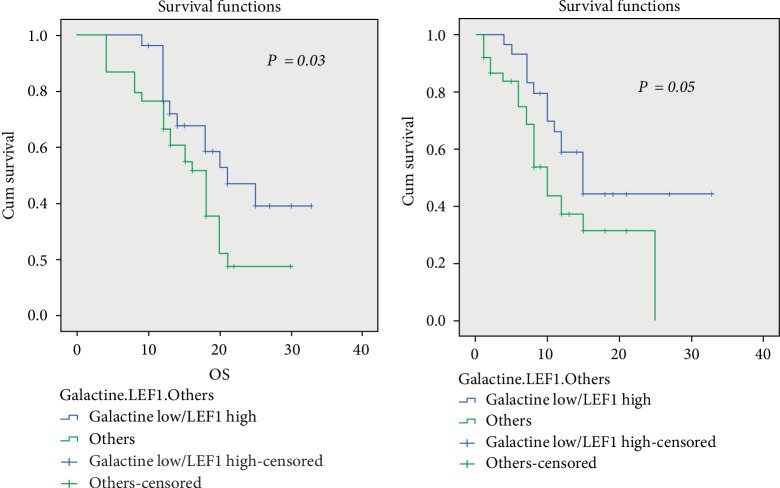
HFL1high/low Gal.3 level were associated with better EFS & OS in AML patients.